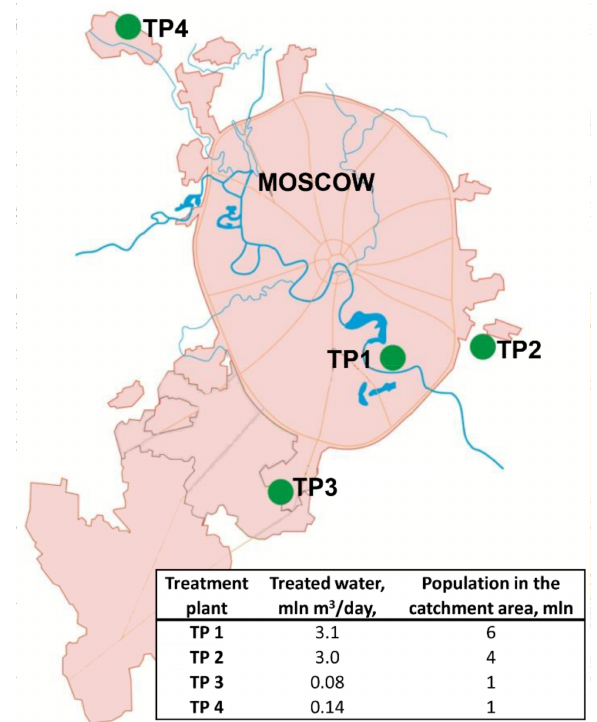
Figure 1. Location, throughput, and population in the catchment area of Moscow sewage treatment plants